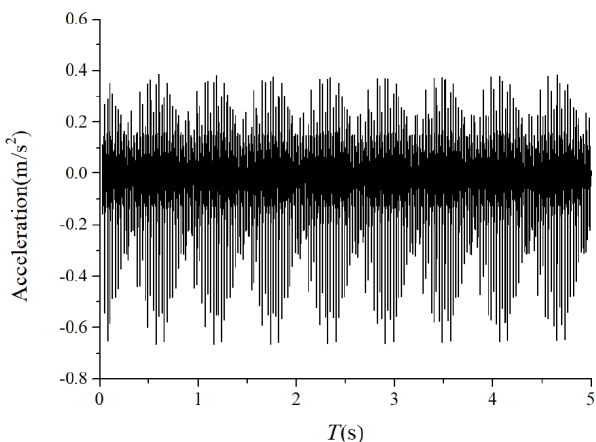
Figure 29. Acceleration waveform.